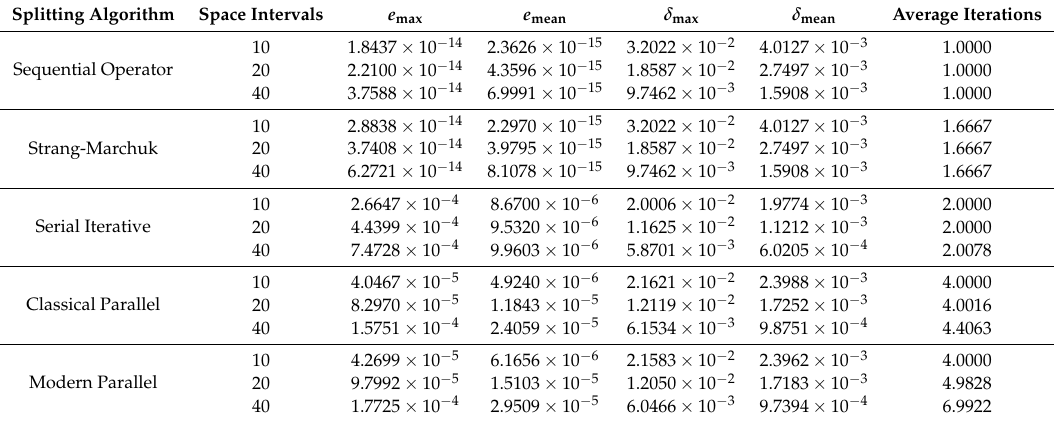
Table 5. Diffusion problem. Results of the directional decomposition using the second order scheme for the spatial discretization, with 320 temporal steps and different number of spatial subintervals. Splitting Algorithm Space Intervals